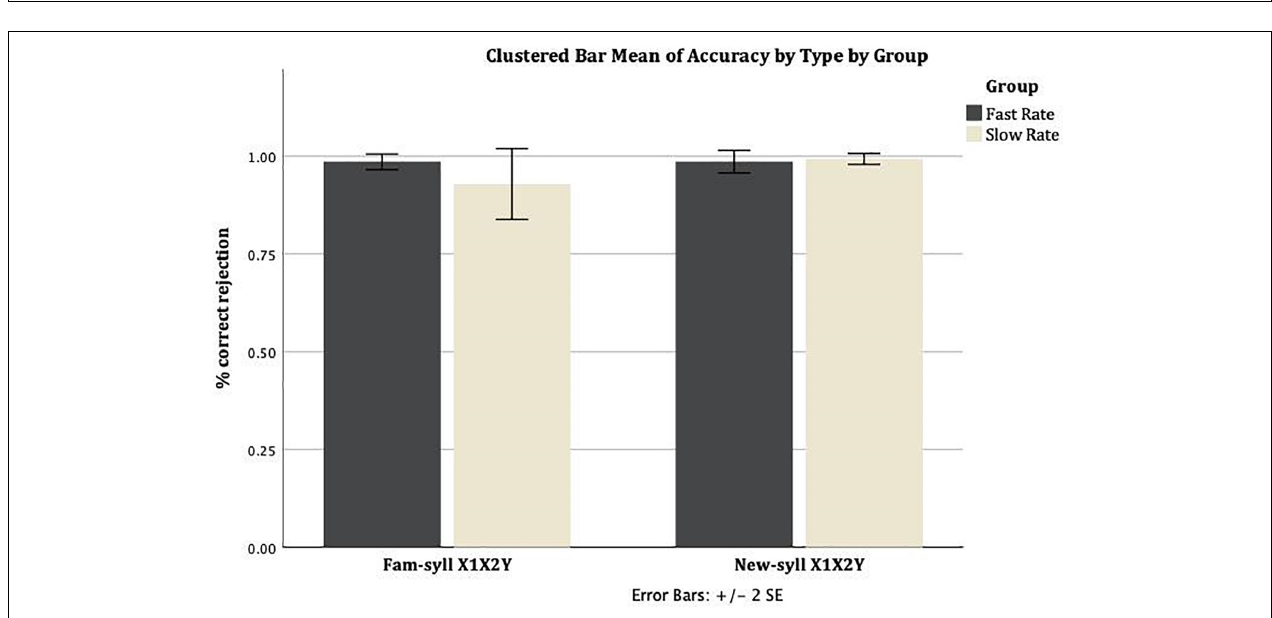
FIGURE 1 | Mean rate of correct acceptance for Familiar-syllable XXY and New-syllable XXY strings in both conditions: Fast Rate and Slow Rate. Error bars show standard error of the mean.